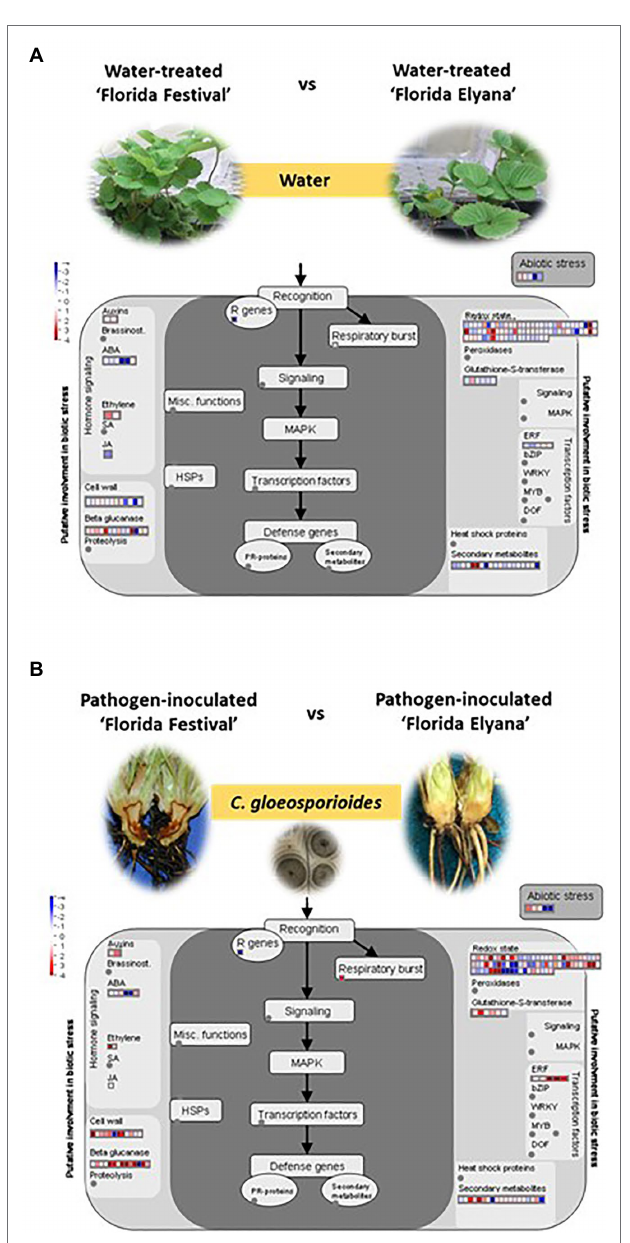
FIGURE 2 | MapMan visualization of DEGs related to different signaling and metabolic pathways under (A) water treatment and (B) pathogen inoculation between ‘Florida Festival’ and ‘Florida Elyana.’ The log2 fold changes of significant DEGs were imported and visualized in MapMan software (3.5.1